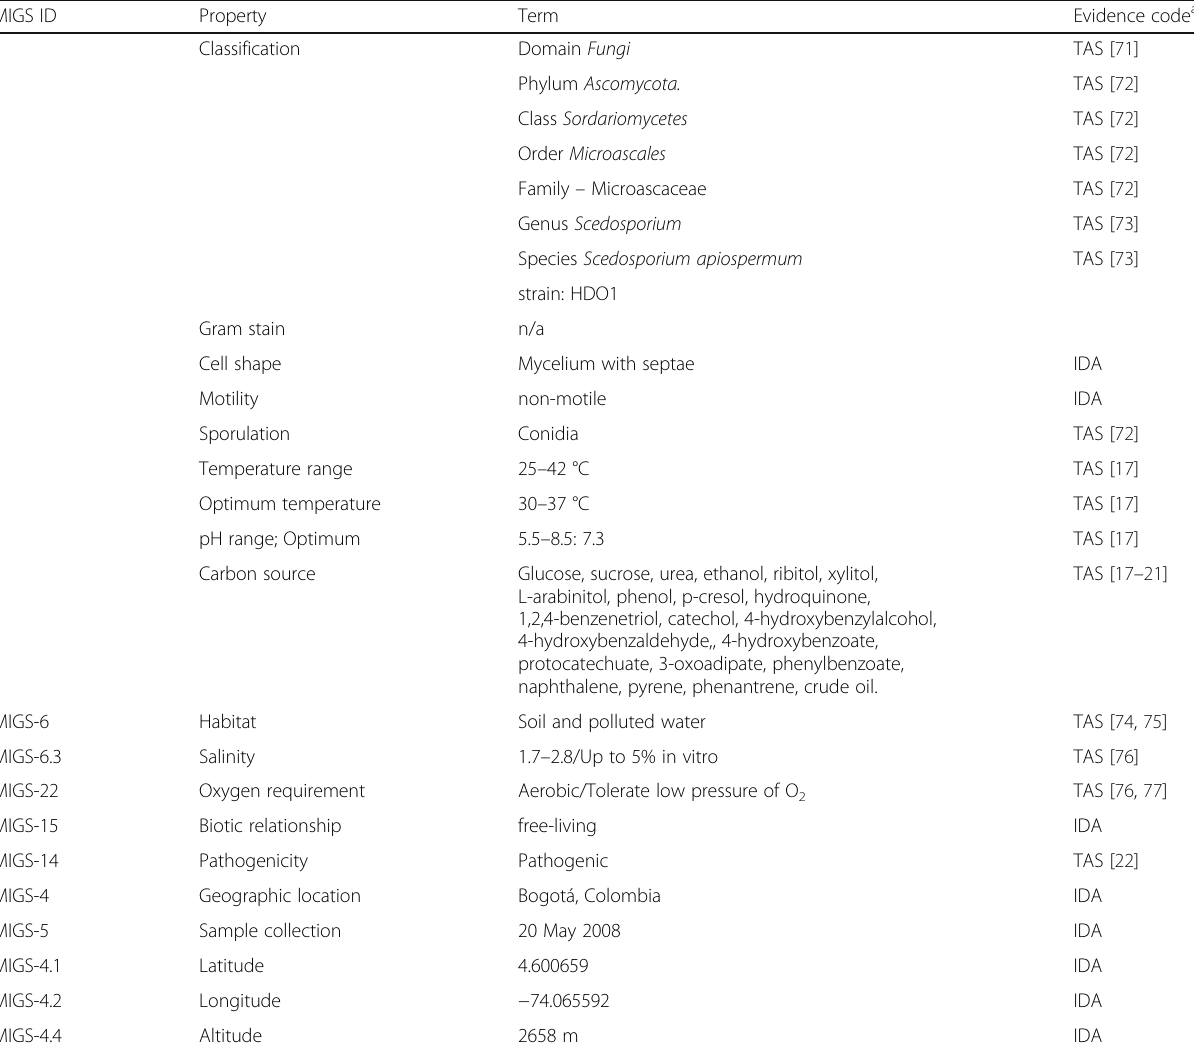
Table 1 Classification and general features of Scedosporium apiospermum strain